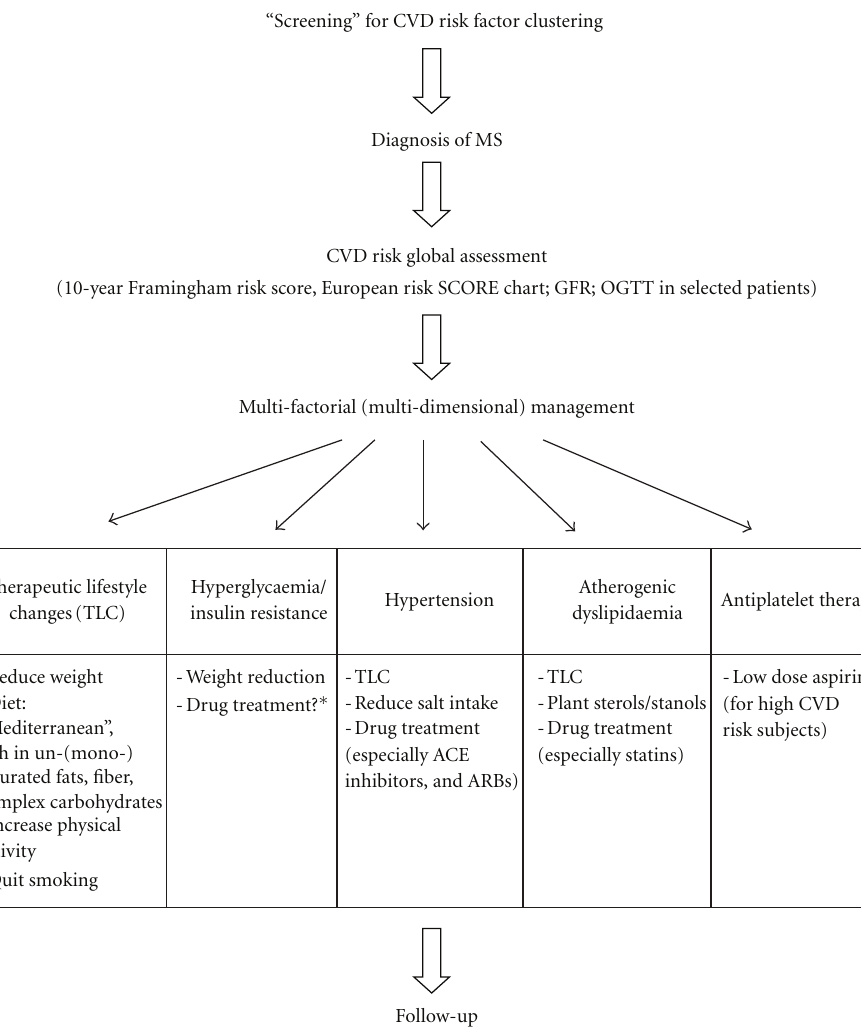
Figure 1: Management of the metabolic syndrome [147] (reproduced with permission). ACE: angiotensin converting enzyme; ARBs: angiotensin II receptor antagonists; CVD: cardiovascular disease; GFR: glomerular filtration rate; MS: metabolic syndrome; OGTT: oral glucose tolerance